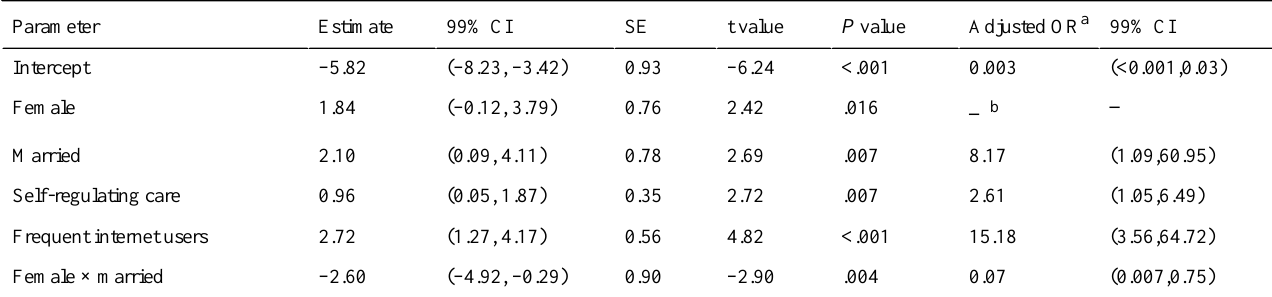
Table 3. Binary logit model for the likelihood of using the internet to schedule an appointment with a health care provider.